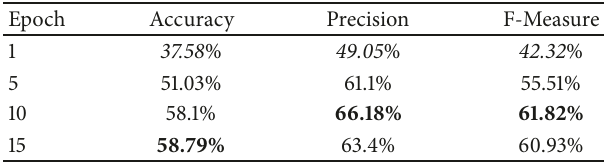
Table 11: Recognition results using LSTM concerning dataset